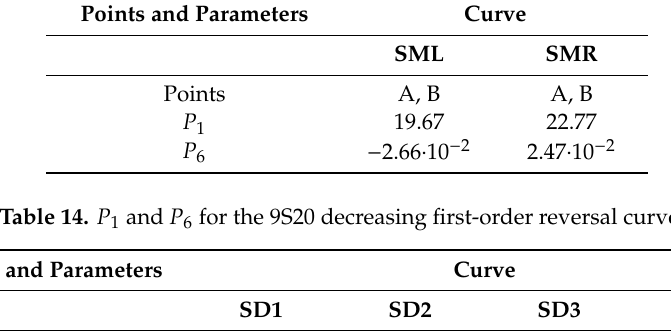
Table 13. P 1 and P 6 for SML and the right part of the measured major hysteresis loop (SMR). Points and Parameters Curve